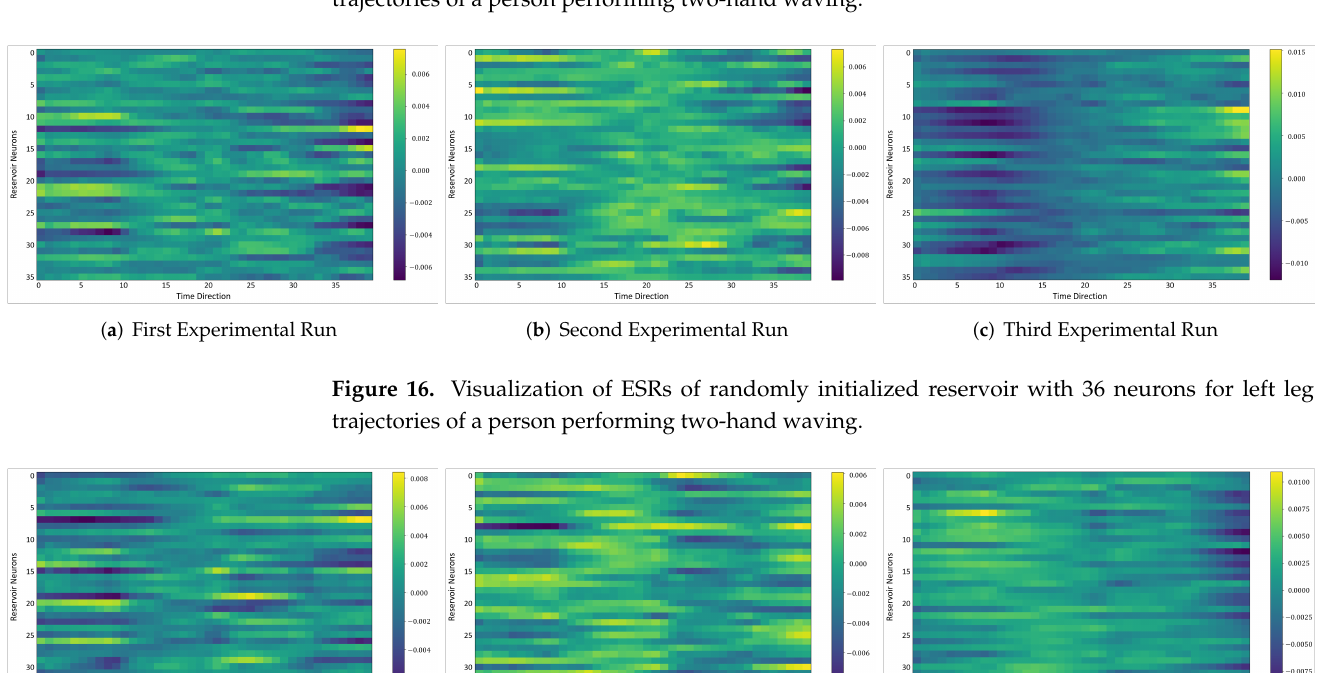
Figure 15. Visualization of ESRs of randomly initialized reservoir with 36 neurons for central trunk trajectories of a person performing two-hand waving.